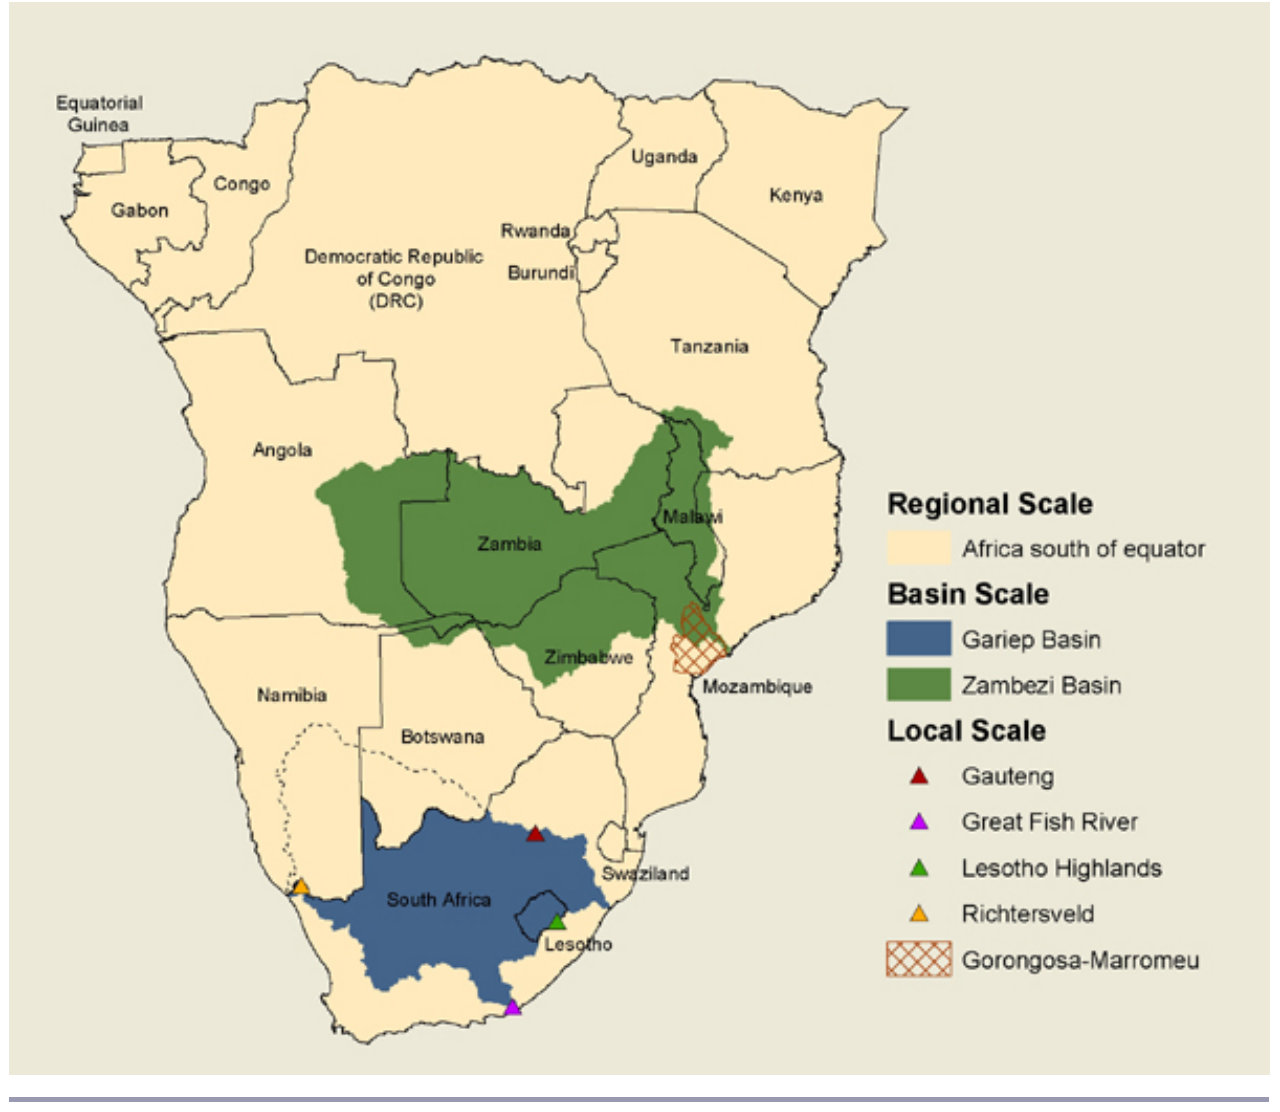
Fig. 1. The Southern African Millennium Ecosystem Assessment study area and its nested, multiscale design. Note that the actual Gariep basin (indicated by a dashed line) extends beyond the area assessed (Biggs et al.